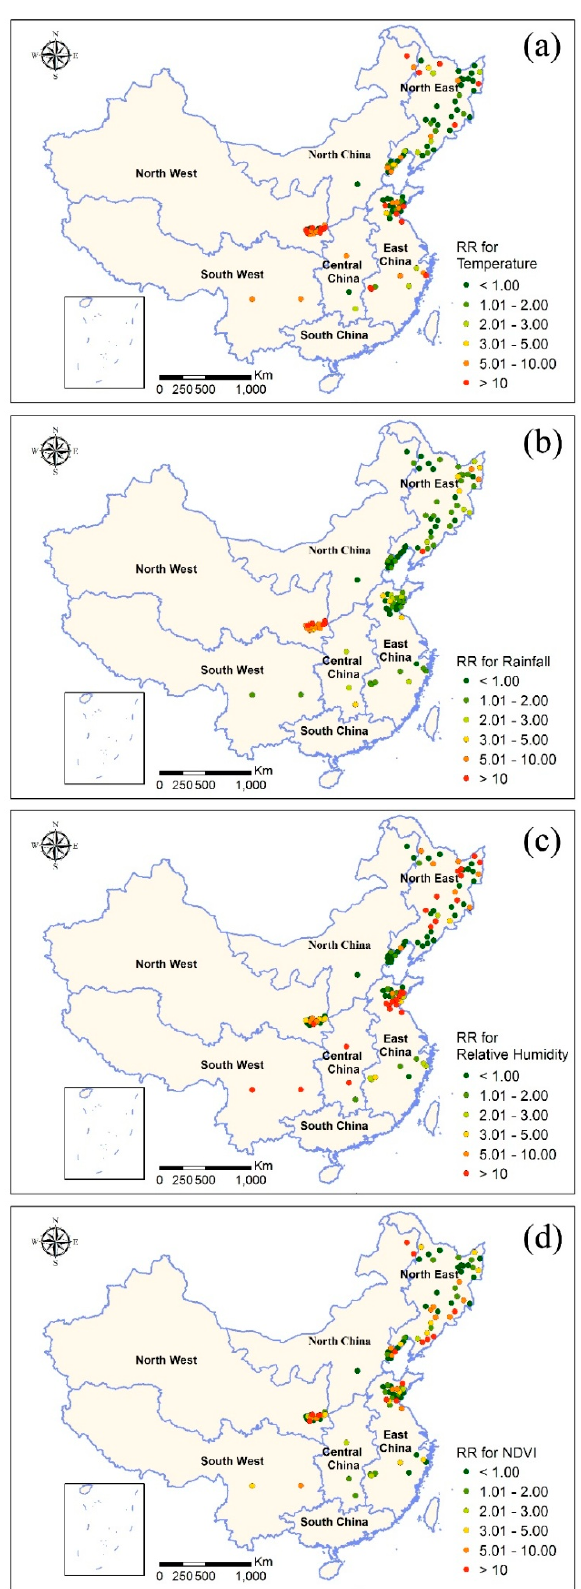
Figure 4. County-specific relative risk of ( a ) mean temperature (50th percentile against 25th percentile), ( b ) rainfall (25th percentile against 0th percentile), ( c ) relative humidity (25th percentile against 0th percentile), and ( d ) NDVI (50th percentile against 25th percentile) on HFRS infection.